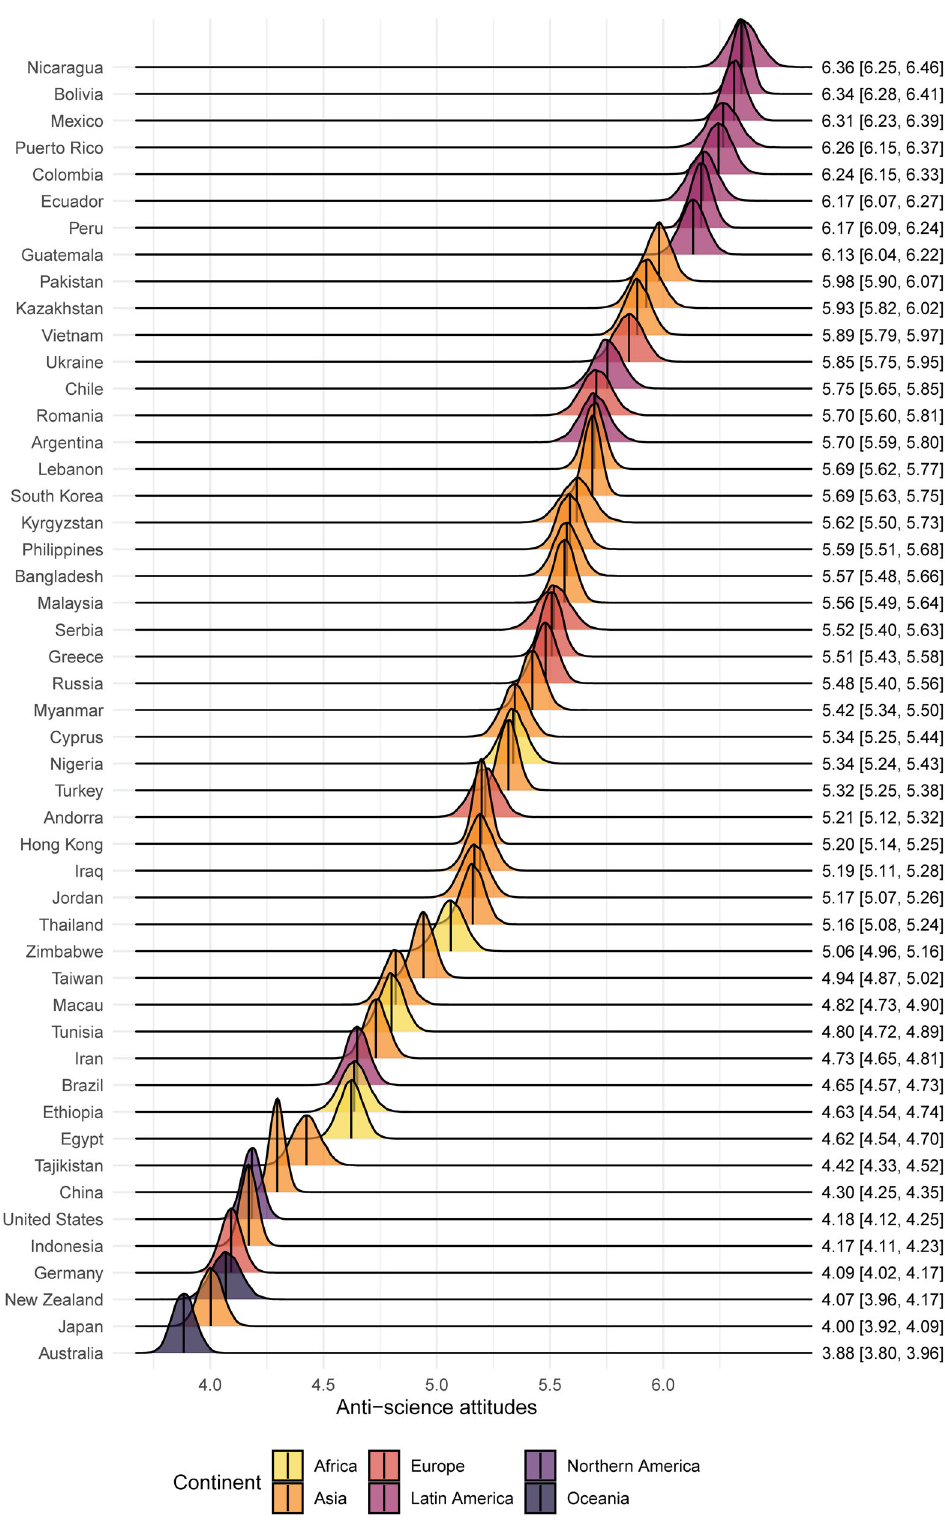
Fig. 1 Posterior probability distributions of anti-science attitudes across countries. Note : Vertical lines represent posterior probability distribution means of intercepts of Bayesian null models fi tted within country subsamples. Values reported indicate distribution means as well as lower and upper bounds of 89% HDIs. Intercept of Bayesian null model fi tted within full sample: 5.23 [5.22,